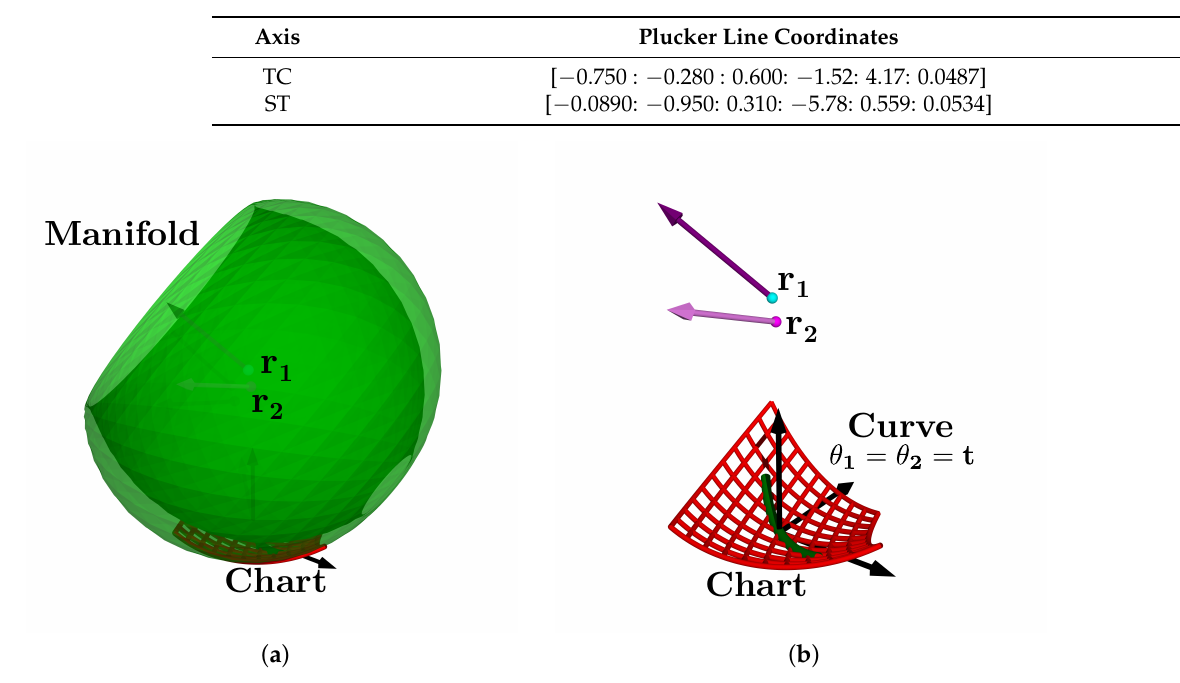
Figure 38. Ankle joint manifold. ( a ) Manifold for PM, ( b ) chart with ankle axis